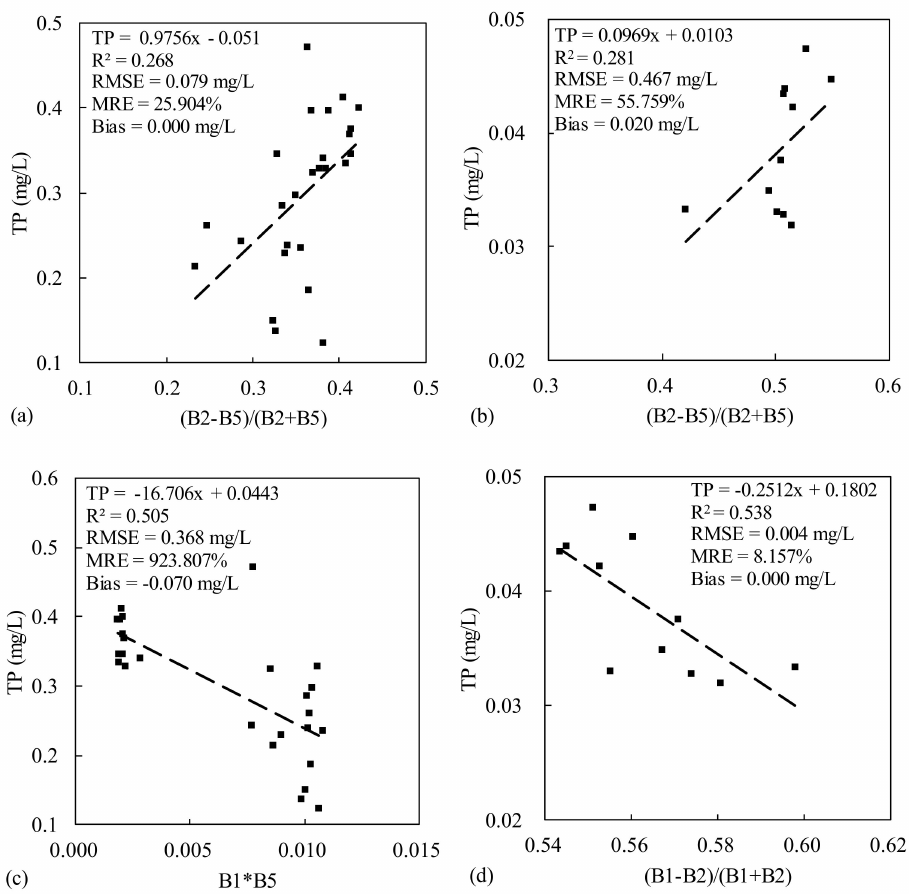
Figure 8. ( a ) Scatter plot of the (B2 − B5) / (B2 + B5) and TP concentration in Lake Chaohu; ( b ) scatter plot of the (B2 − B5) / (B2 + B5) and TP concentration in Lake Nanyi; ( c ) scatter plot of the B1*B5 and TP concentration in Lake Chaohu; ( d ) scatter plot of the (B1 − B2) / (B1 + B2) and TP concentration in Lake